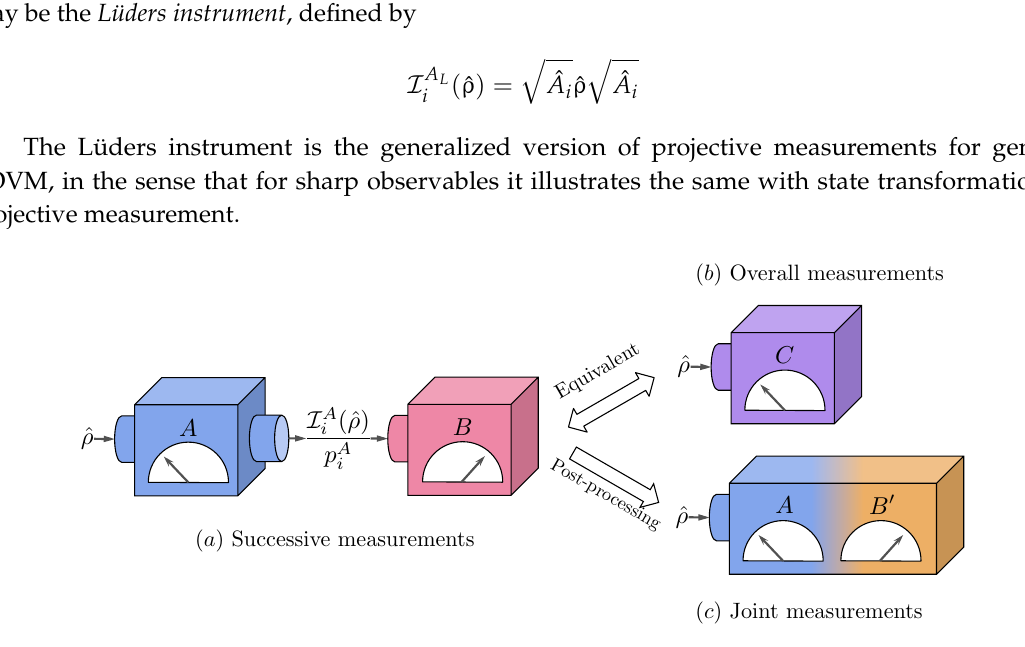
A ( ρ ) / p A ( i ) conditioned on its outcome i ; i I